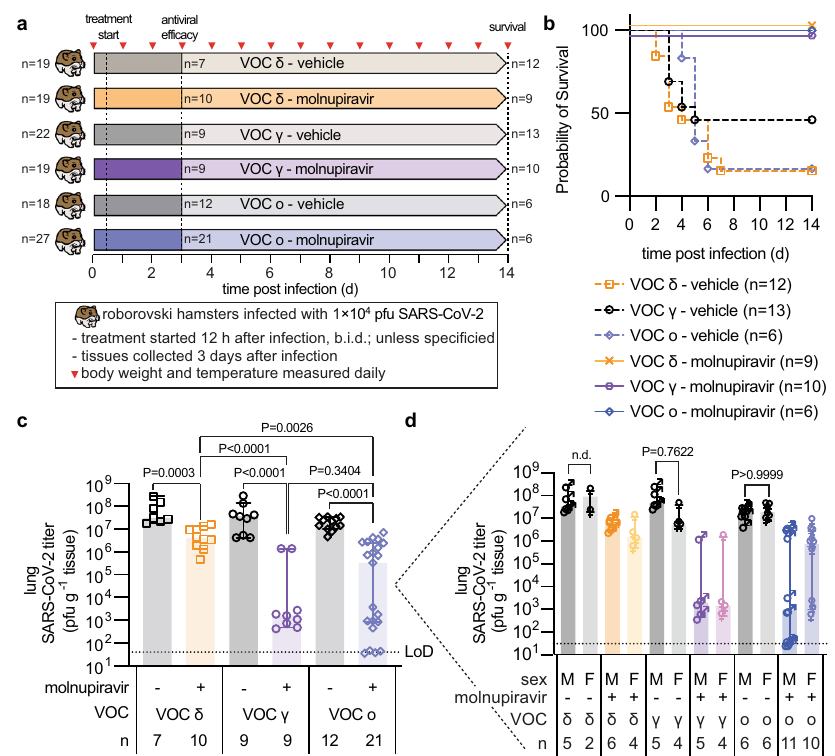
Fig. 4 | Effects of therapeutic molnupiravir on SARS-CoV-2 lung virus load. a Schematicofthedwarfhamsteref fi cacystudy.Animalsweremonitoredforupto 14 days after intranasal infection with 1×10 4 pfu each. Clinical signs were assessed once daily (red triangles). Groups of dwarf hamsters were euthanized 3 days after infection to assess viral load and perform histological examinations. b Survival curvesofinfecteddwarfhamstersfrom a . c Infectioustitersfromthelungsofdwarf